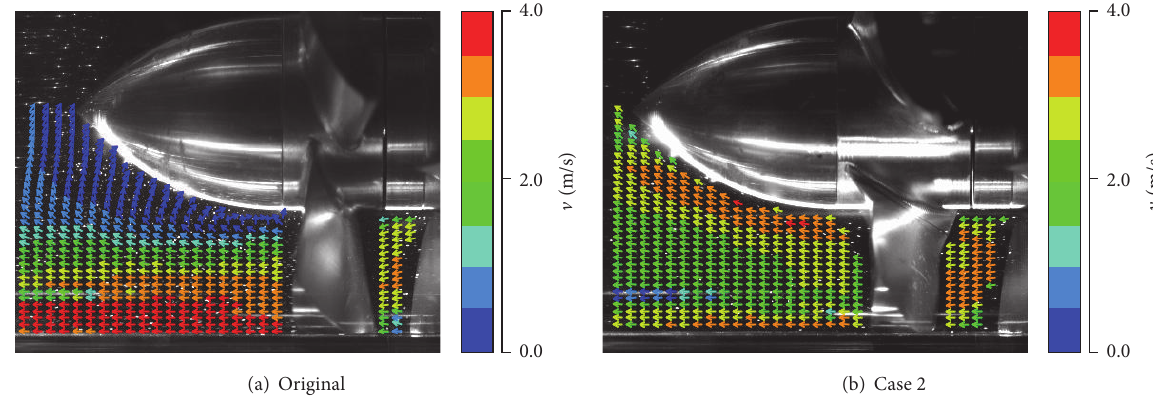
Figure 17: Absolute velocity vector ( 𝑛 = 2460 min −1 , Exp.).